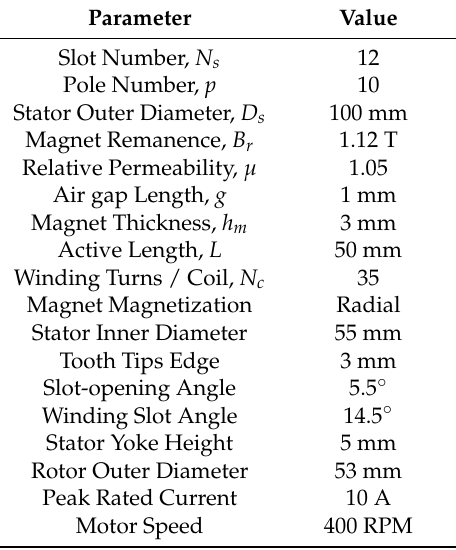
Table 1. Main Motor